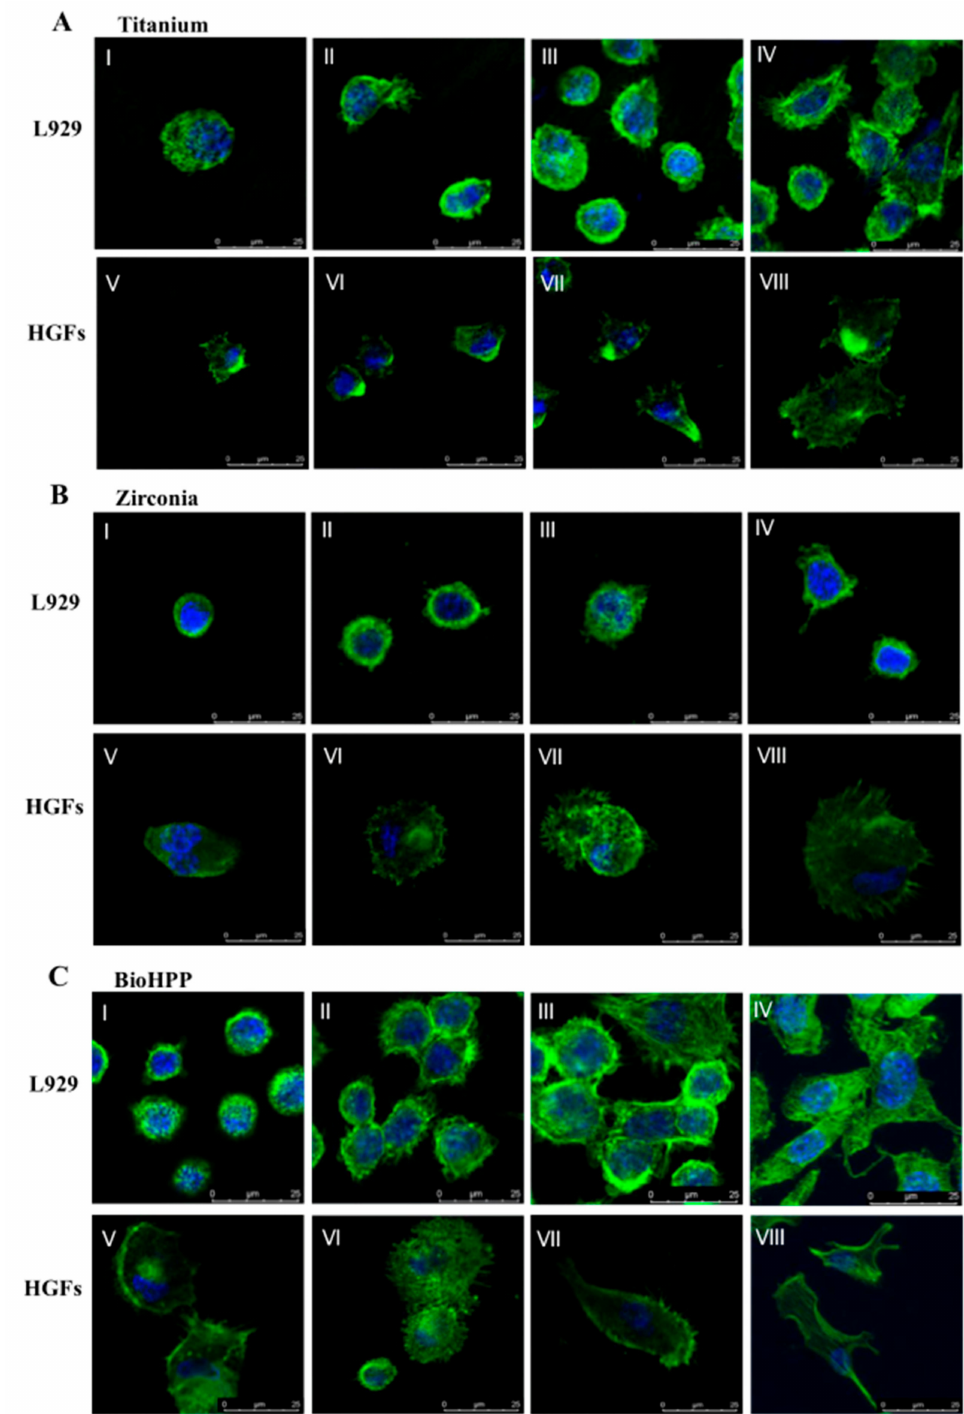
Figure A1. Cell attachment and morphology on di ff erent surface-treated titanium, zirconia and BioHPP after 2